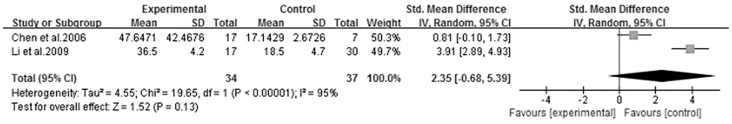
Forest plot of the effect of CBP on the duration of liquefaction.